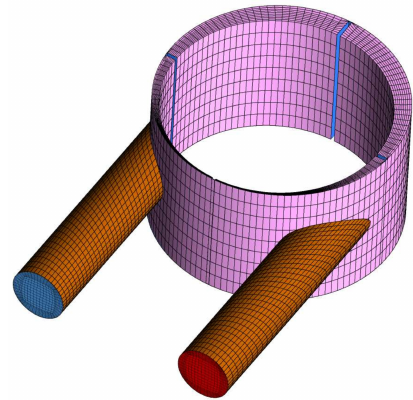
Figure 2. The initial position of the numerical mesh of the computational model at crank angle φ = 0 ◦ . The working fluid flow was modelled as a compressible, turbulent, and single-phase Redlich–Kwong gas. The specific heat capacity of each tested medium was set as a function of temperature. The wall boundary was assumed adiabatic due to the brief time spent by a portion of the fluid inside the machine (see Table